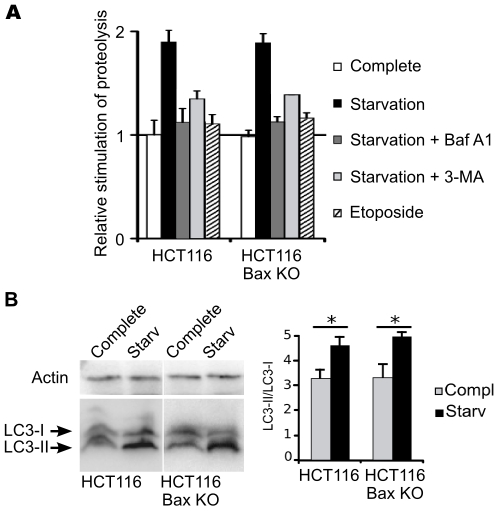
HCT116 and HCT116-BaxKO cells display comparable autophagic capacities.(A) HCT116 and HCT116-BaxKO cells were incubated with L-[14C]valine, and chased for 9 hours in complete medium (white bars), HBSS (black bars) or HBSS supplemented with either 0,1 µM Baf A1 (dark gray bars), or 10 mM 3-MA (light gray bars), or in complete medium +20 µM etoposide (hatched bars). Results report the stimulation of proteolysis relative to the respective basal levels measured under non-starving conditions (white bars). The values are the means of at least 3 independent experiments ± s.d. (B) Western blot and quantification of the conversion of LC3-I into phosphatidylethanolamine-conjugated LC3-II. Cells were grown in complete medium or starved for 9 h in the presence of E-64d (20 µg/ml) and leupeptine (20 µg/ml) to prevent the degradation of intra-autophagosomal LC3-II. 150 µg whole cell lysate were loaded on 15% SDS-PAGE. *Student test p<0,02.